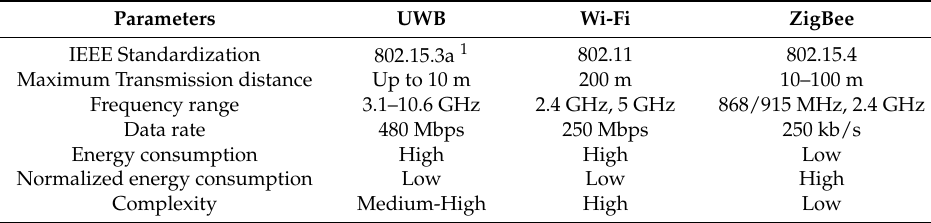
Table 1. Comparison of UWB, Wi-Fi and